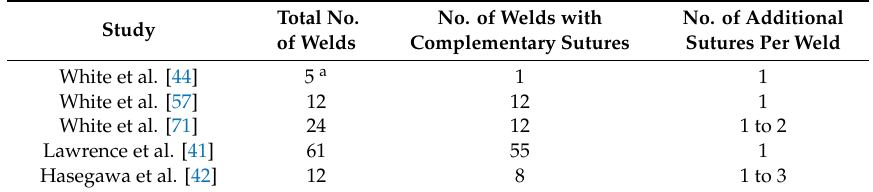
Figure 2. Instrumentation for preloaded longitudinal compression: ( a ) Vessel clamp device (prototype); ( b ) Procedure of preloaded longitudinal compression [48]. Table 2. Laser welding with complementary sutures in vascular and nerve surgeries.